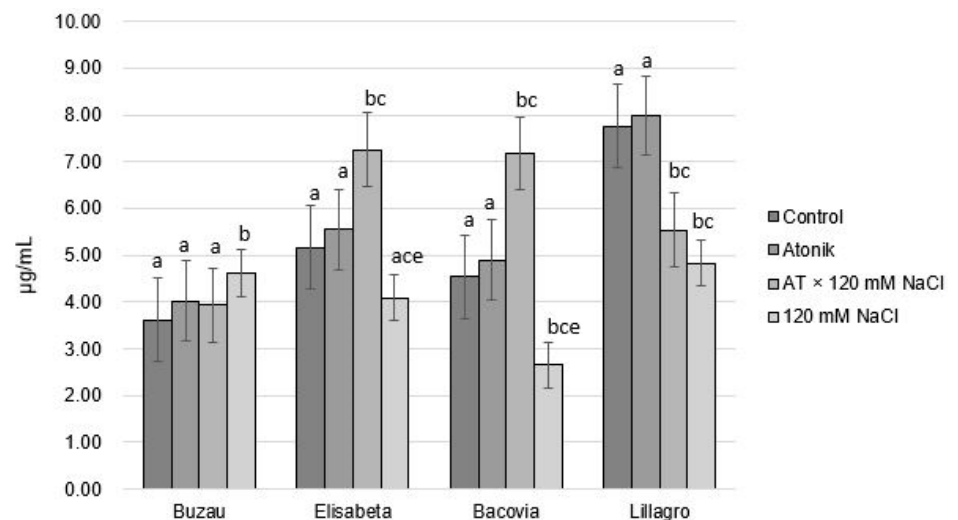
Figure 7. The effect of Atonik biostimulant on the concentration of chlorophyll a under saline stress after the third treatment. Different letters mean significant differences, according to the Tukey test. Error bars indicate ±SD.